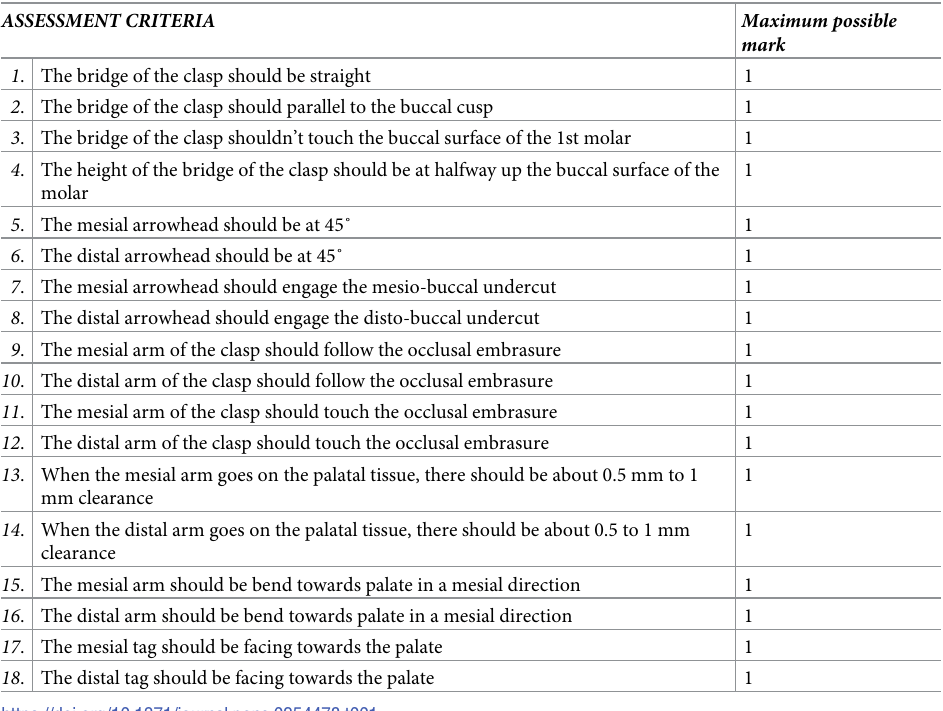
Table 1. 18-item rubric for Adams clasp quality assessment. ASSESSMENT